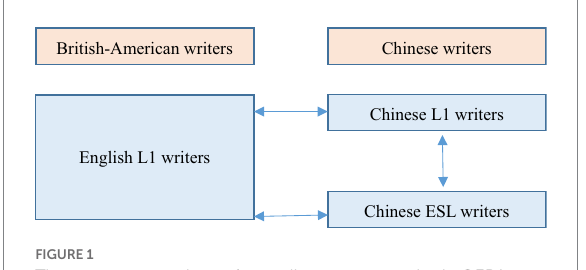
FIGURE 1 Three-way comparison of metadiscourse strategies in